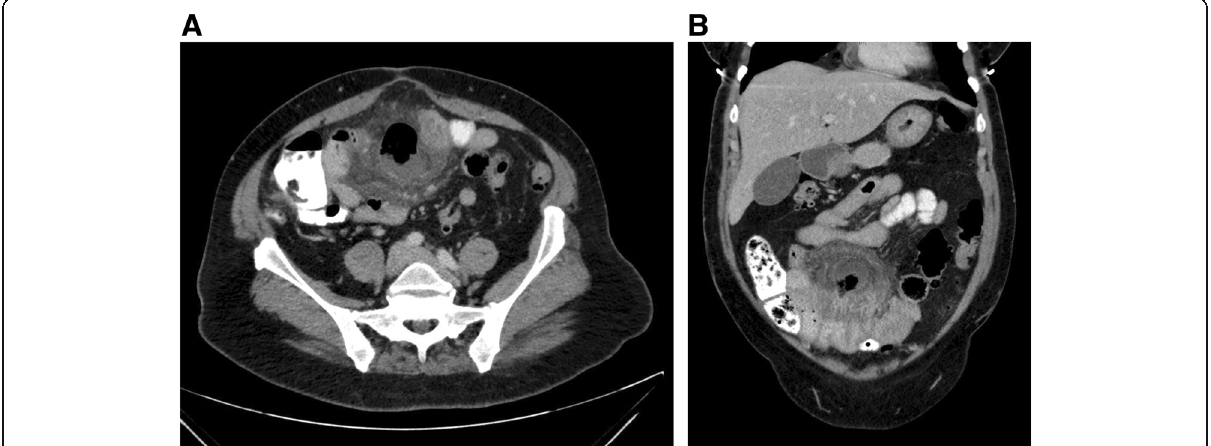
Fig. 1 CT of the abdomen with oral and IV contrast. a Axial image of the mid-jejunal diverticulum with perforation. b Coronal image demonstrating associated edema of the jejunal loop and adjacent